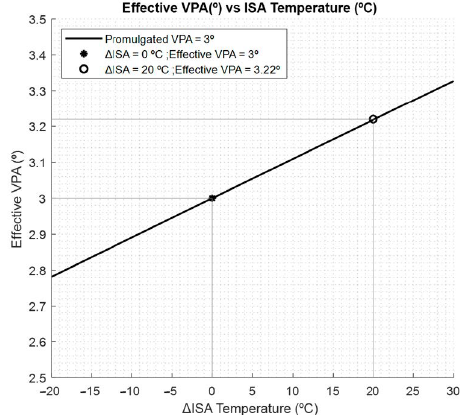
Figure 1. Δ ISA airport temperature vs. e ff ective VPA.